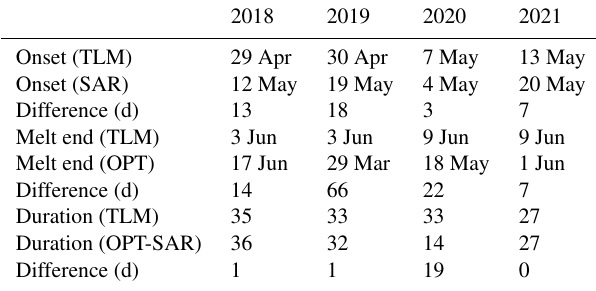
Table 7. Comparison of multi-source and SWE estimates of snowmelt end, onset, and duration at Green Mountain. The differ- ence in days is provided between telemetry-based (TLM) estimates of melt and SAR, optical (OPT), and optical-radar (OPT-SAR) es- timates of